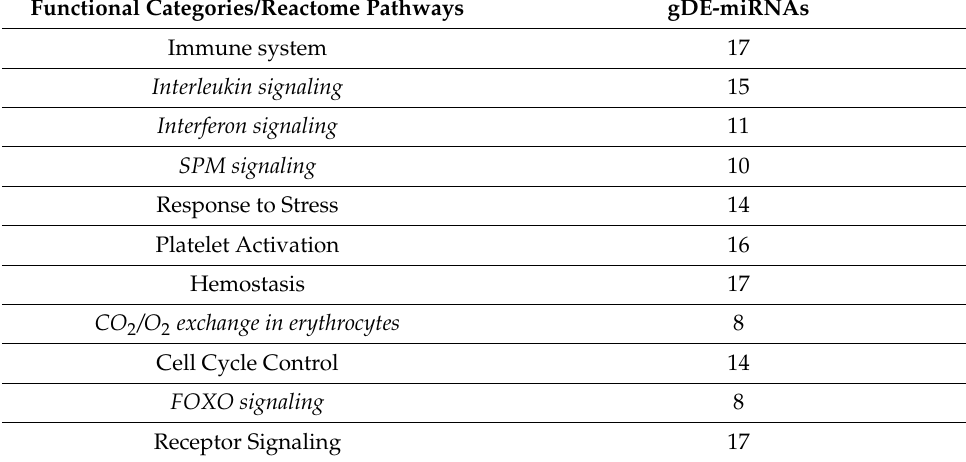
Table 10. Distribution of the 17 HK gDE-miRNAs targeting at least one gene in the enriched functional categories and selected reactome pathways. Pathways indicated in italics below the